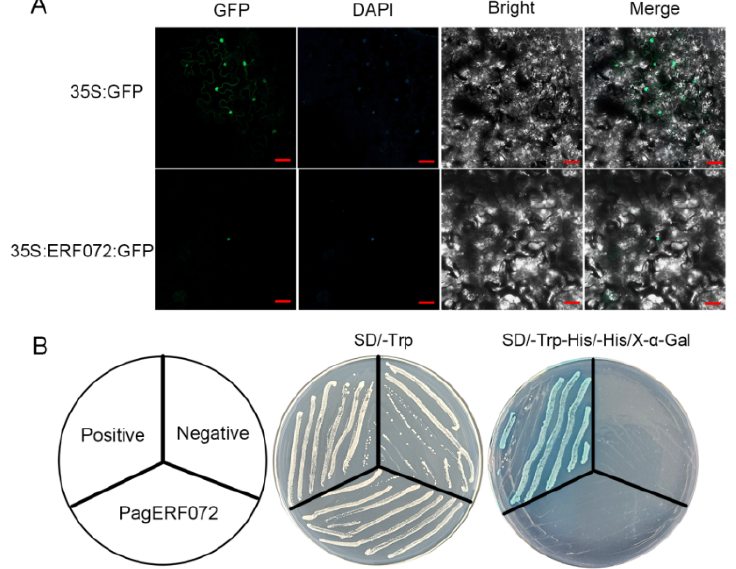
Figure 4. Subcellular localization and transcriptional activation of PagERF072. ( A ) Subcellular localization of PagERF072 protein. Scale bar = 20 µm. ( B ) Transcriptional activation of PagERF072 protein.